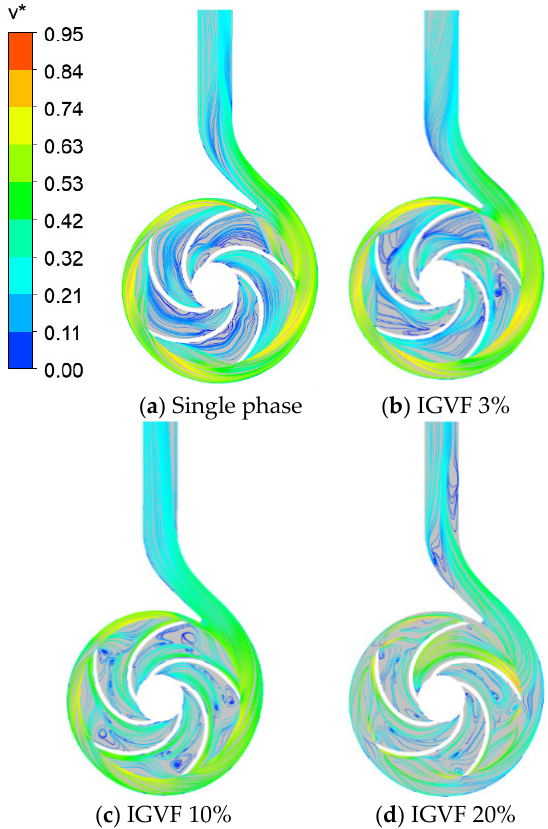
Figure 9. Velocity streamline distribution under single phase and different IGVF.